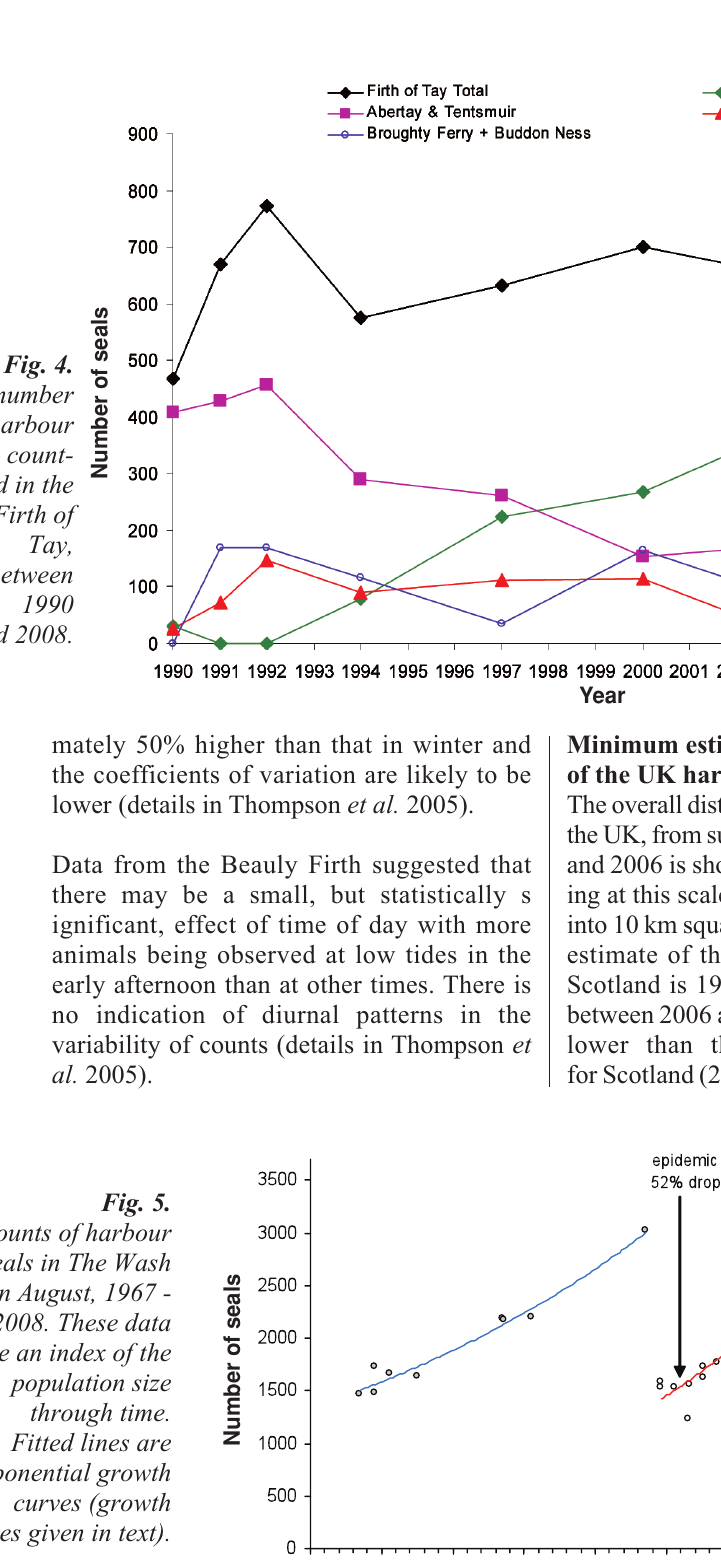
Counts of harbour seals in The Wash in August, 1967 - 2008. These data are an index of the population size through time. Fitted lines are exponential growth curves (growth rates given in